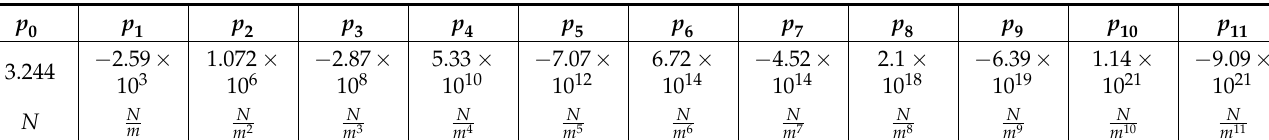
Table 1. Polynomial coefficients p j